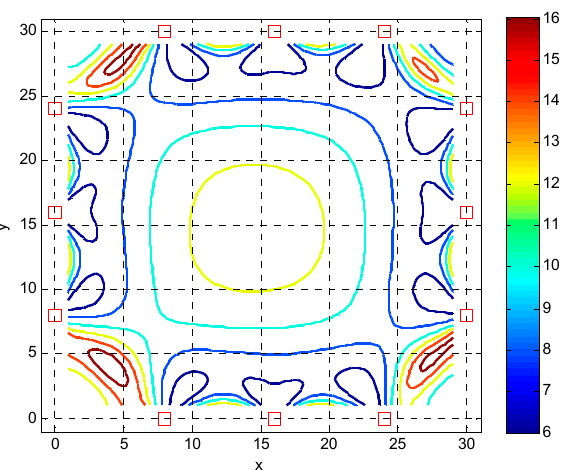
Figure 6. Cramer Rao Bound (CRB) of the magnitude of location estimate as a function of J xx ( x MWD , y MWD ) with red squares indicating the location of the APs with 8 m separation.